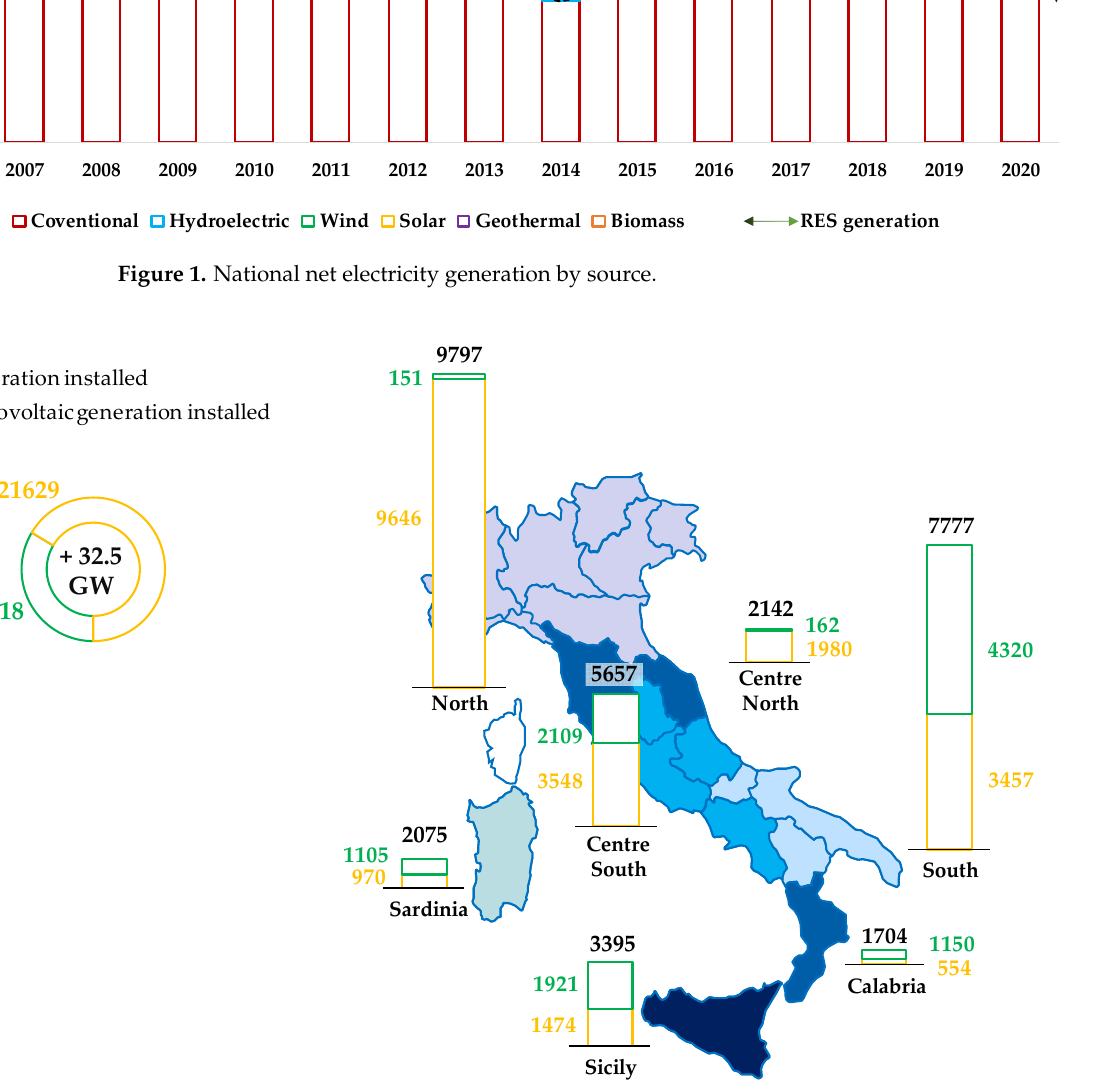
Figure 2. Solar photovoltaic and wind generation installed in Italy, December 2020 update. Regions of the same color belong to the same market zone of the Italian power system.